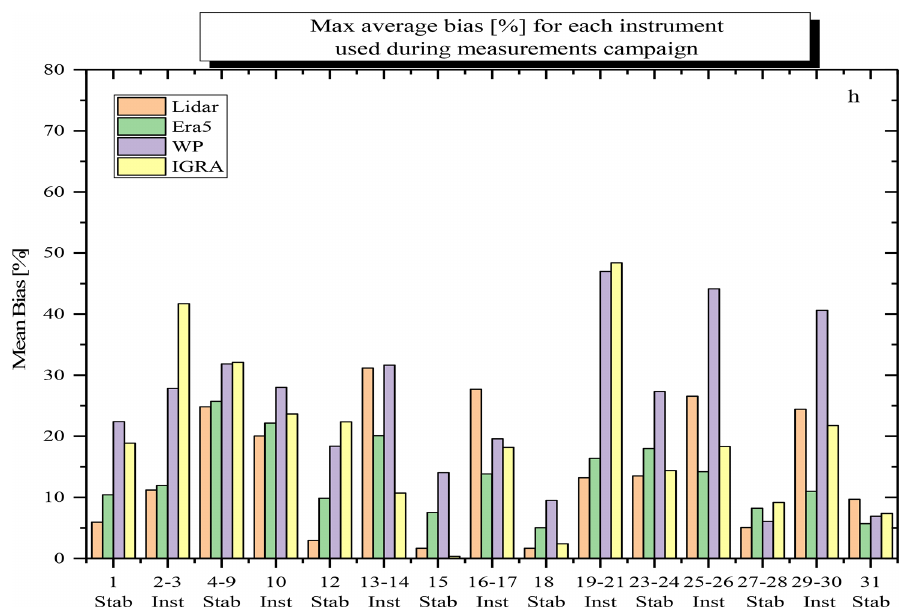
Figure 5. Percentage bias of the different ABLH estimates with respect to the one obtained through the application of the Richardson number approach to the on-site radiosonde profiles, expressed as a function of the atmospheric stability conditions.